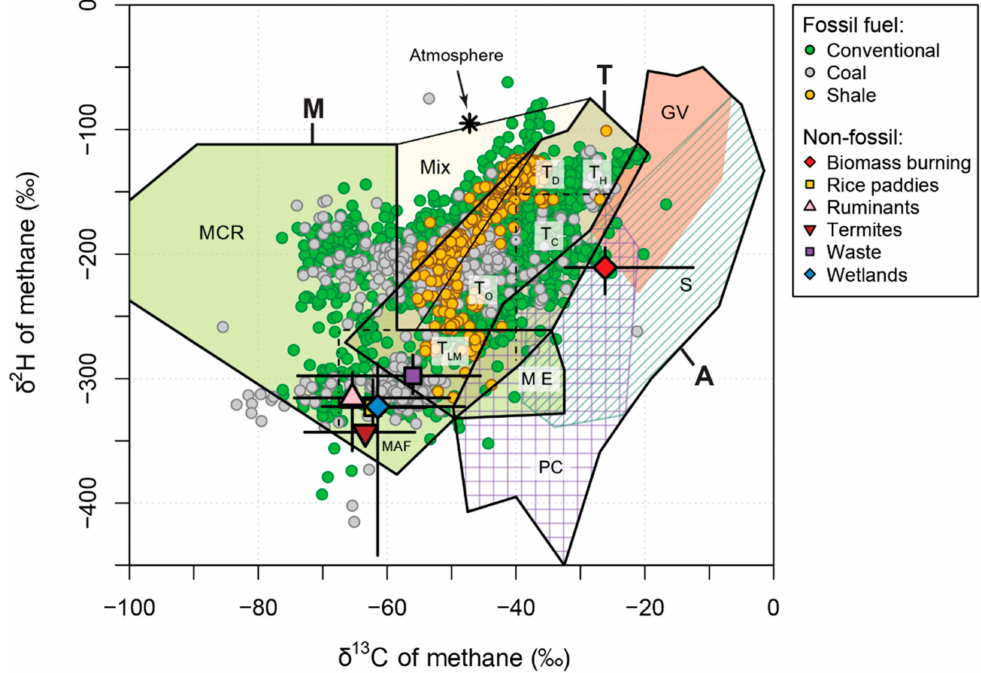
Figure 3. Plot of δ 13 C(CH 4 ) against δ 2 H(CH 4 ) showing a possibility to categorize methane emissions according to the emission pathway. M, microbial; T, thermogenic; A, abiotic; MCR, microbial CO 2 reduction; MAF, microbial acetate fermentation; ME, microbial in evaporitic environment; T O , thermogenic with oil; T C , thermogenic with condensate; T D , dry thermogenic; T H , thermogenic with high-temperature CO 2 –CH 4 equilibration; T LM , thermogenic low maturity; GV, geothermal-volcanic systems; S, serpentinized ultramafic rocks; PC, Precambrian crystalline shields. Illustration and abbreviation explanation directly taken from [37], licensed under CC BY 3.0. Available at https: // www.earth-syst-sci-data.net / 9 / 639 / 2017 / essd-9-639-2017.pdf. Reproduced with permission from [37]. Copernicus Publication, 2017 under CC BY